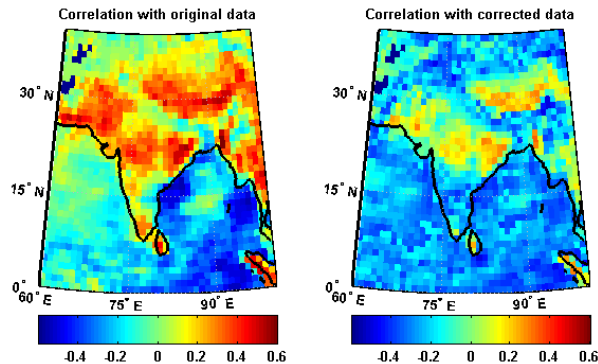
Fig. 7. Spatial pattern of correlation of time series of deep convec- tive cloud amount at each grid point with the time of observation Fig. 7: Spatial pattern of correlation of time series of deep convective cloud amount at for the original AVHRR dataset (left panel) and after drift signal re- each grid point with the time of observation for the original AVHRR dataset (left panel) moval (right panel). The correlations are reduced considerably in and after drift signal removal (right panel). The correlations are reduced considerably in the latter case. the latter case.